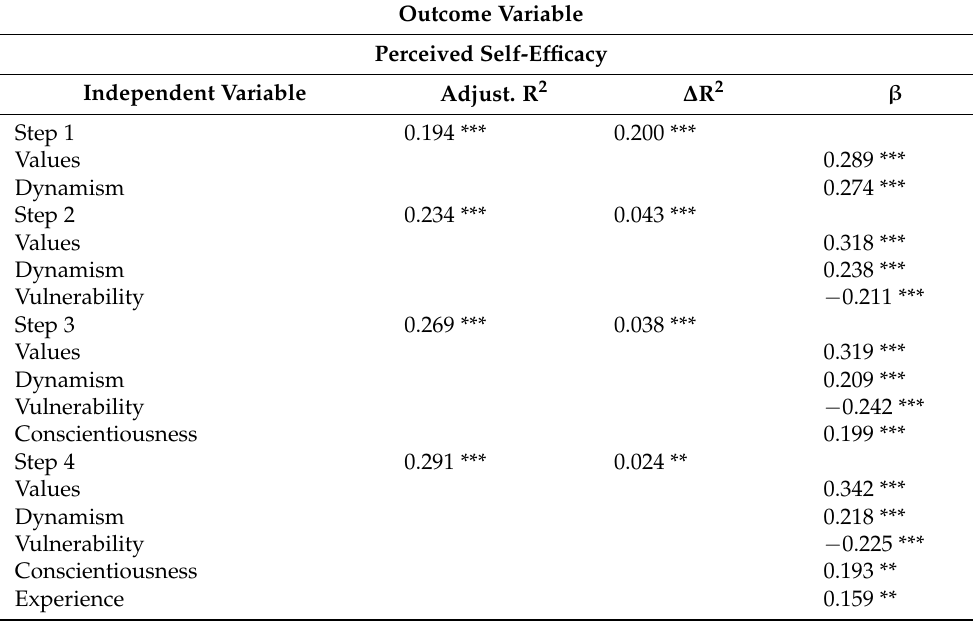
Table 4. Results of Hierarchical Linear Regression Analyses with whole